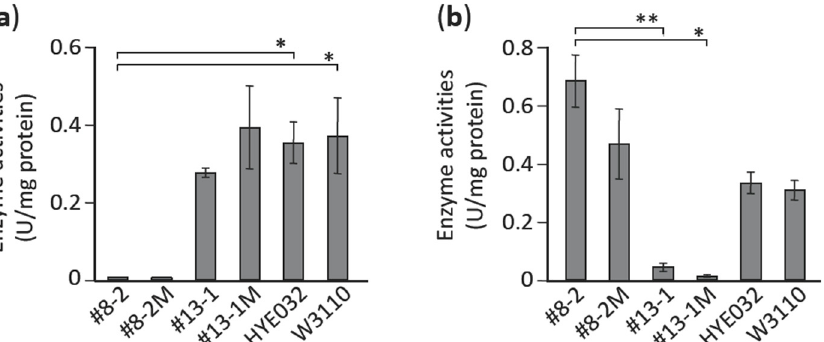
Figure 5. Enzyme activities of pyruvate transacetylase ( a ) and pyruvate dehydrogenase ( b ) in L- alanine suppressors #8-2 and #13-1 and their cognate isogenic mutants #8-2M and #13-1M. Data represent means and standard deviation of 3 independent experiments. Statistical analyses in ( a ) * p < 0.05 and ( b ) * p < 0.01, ** p < 0.001.